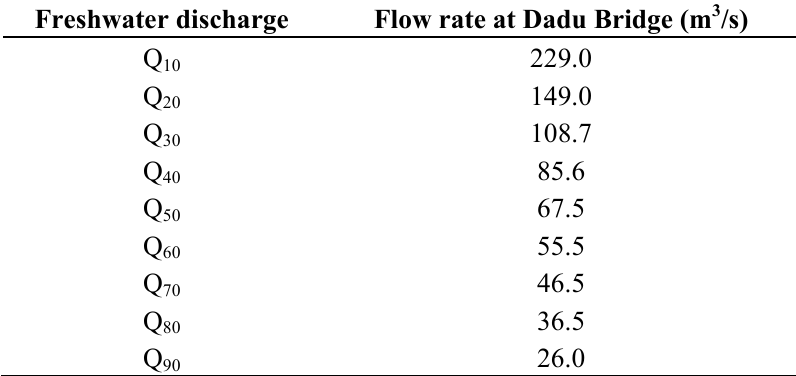
Table 2. Freshwater discharge at upstream boundaries for the model